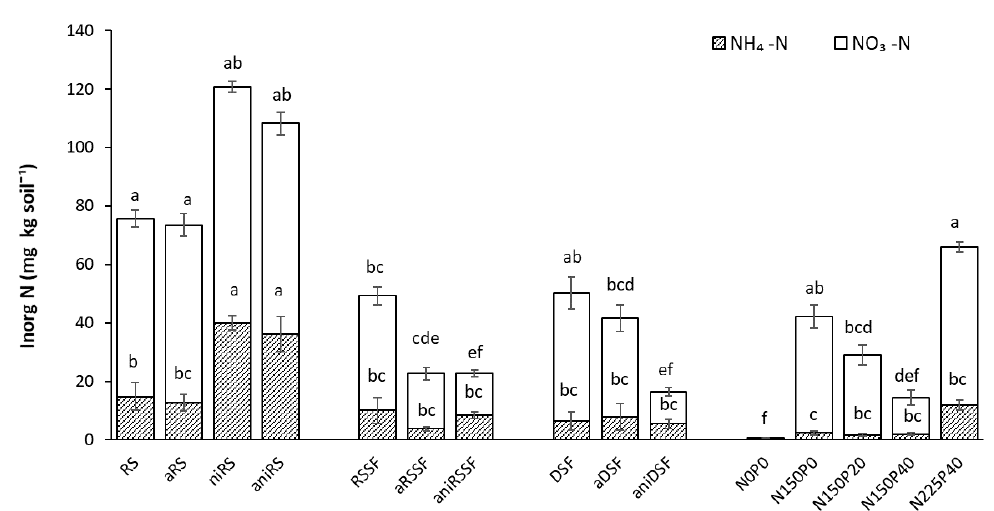
Figure 8. Inorganic N (NO 3 -N + NH 4 -N) in soils applied with untreated and acidified products and reference mineral fertilizers 35 DAS as mean values of 4 replicates. RS: Raw slurry; RSSF: Raw slurry solid fraction; DSF: Digestate solid fraction; a: Acidified; ni: Nitrification inhibitor; ani: acid + ni; NxPy: mineral N and P reference fertilizer at x mg N and y mg P kg − 1 soil. Error bars represent standard error of the mean ( n = 4). Treatments with di ff erent letters, for each mineral N type and across all levels, are significantly di ff erent ( p < 0.05) according to the Tukey test.